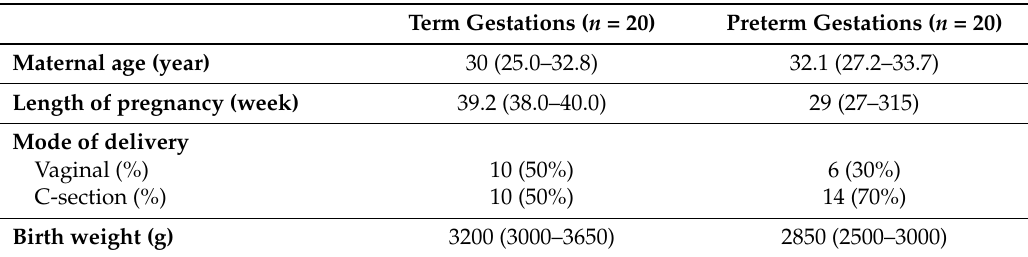
Table 1. Clinical characteristics of mother-infant pair included in the